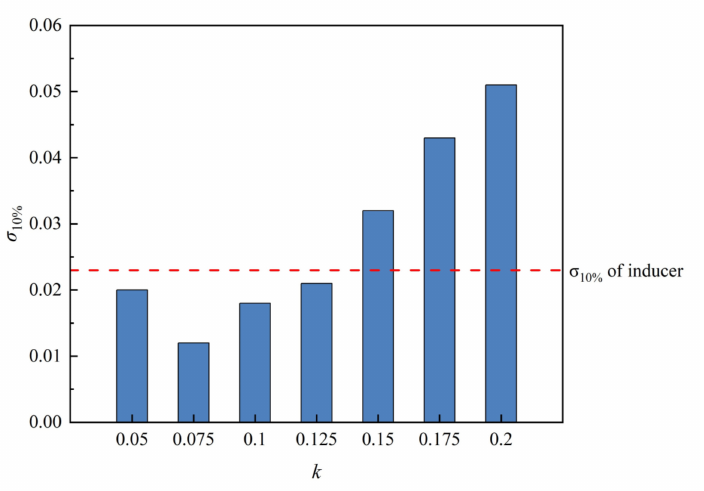
Figure 10. Comparison of external characteristic under different radial